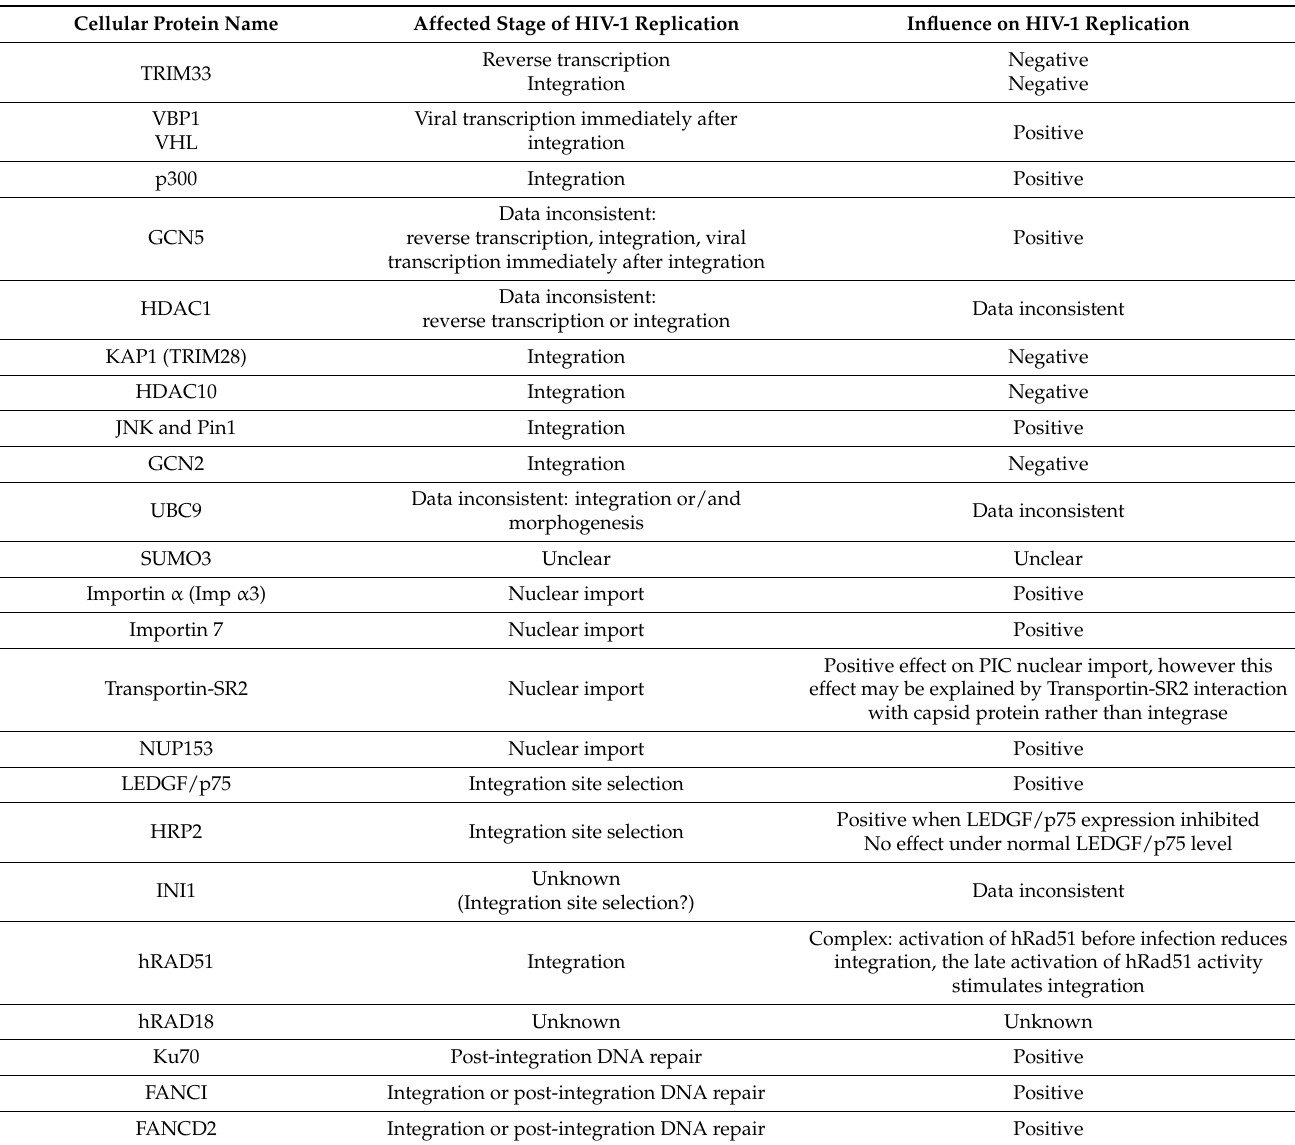
Table 1. Effects of cellular proteins interacting with HIV-1 on viral